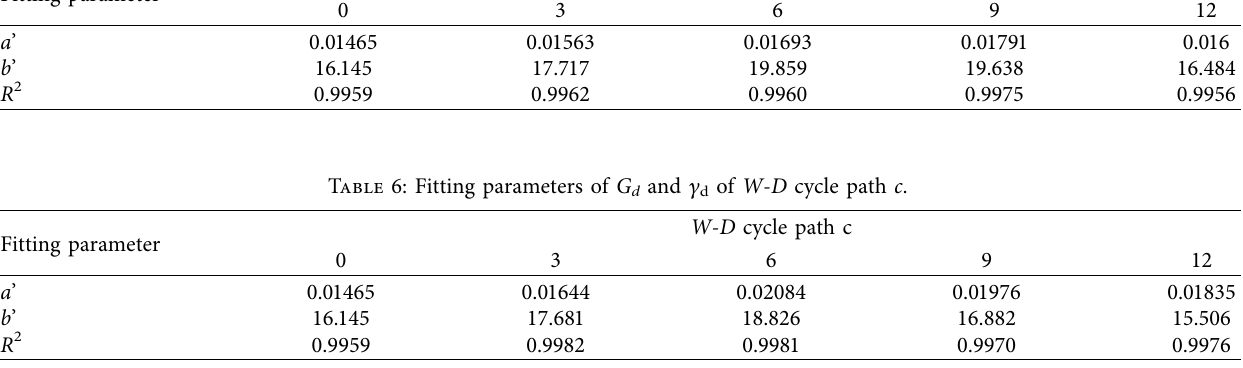
Table 5: Fitting parameters of G